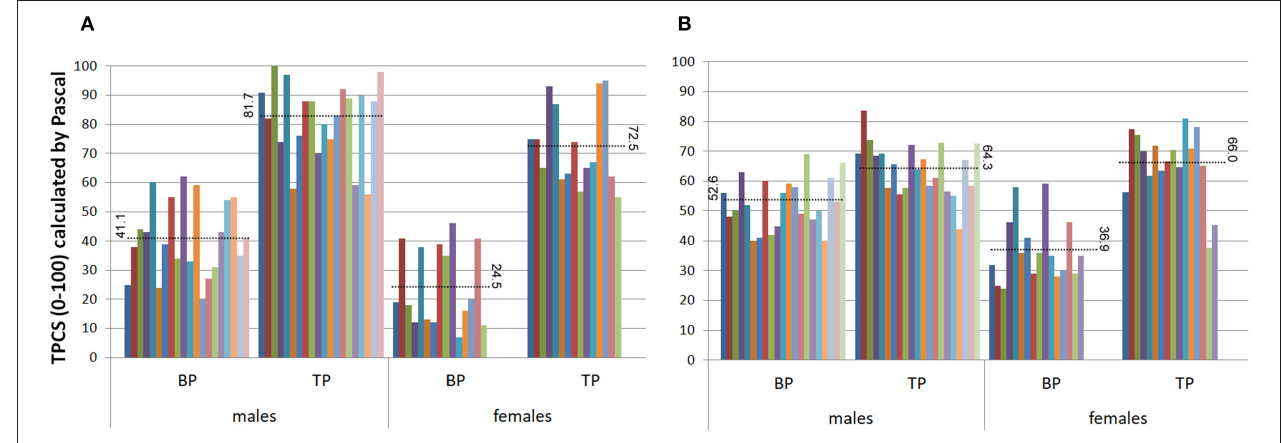
FIGURE 2 | The TPCSs per participant, recording, and course type. Dotted lines show BP/TP means. (A) 12-week course, 20m + 15f. (B) 4-hour course, 21m + 16f.